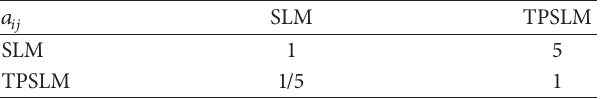
Table 7: Judgment matrix of active power fitting degree.